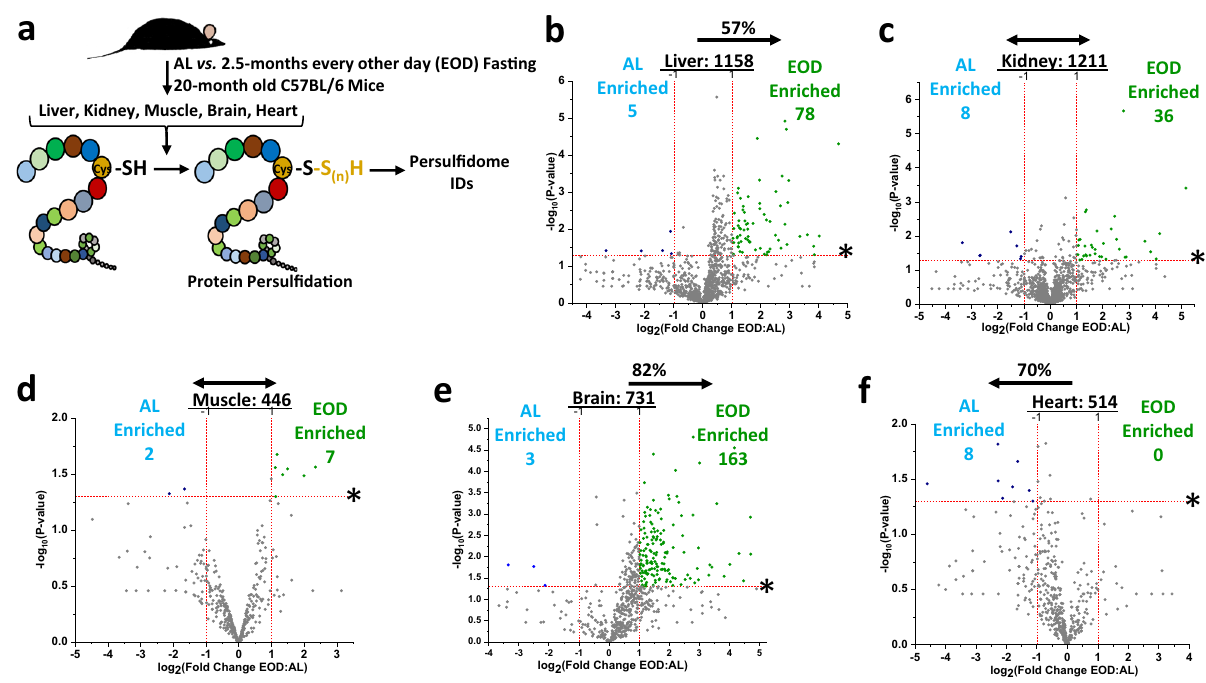
Fig. 5 Late-life initiated every other day (EOD) fasting for 2.5 months transforms tissue-speci fi c persul fi domes similar to short-term DR in young adult mice. a Graphical presentation of the overarching experimental setup. Twenty-month-old male C57BL/6 mice were placed on ad libitum (AL) or Every Other Day (EOD) fasting for 2.5 months prior to tissue collection. Tissues were analyzed for protein persul fi dation via the biotin thiol (BTA) assay. b – f Volcano plots showing differentially abundant persul fi dated proteins in liver ( b ), kidney ( c ), quadriceps muscle ( d ), whole brain ( e ), and heart ( f ) from AL fed ( n = 5 mice/group) versus 2.5 months of EOD fasting ( n = 5 mice/group) 20-month-old C57BL/6 male mice. The log 2 (Fold Change DR:AL) X-axis displays the average fold change in spectral counts for each identi fi ed persul fi dated protein while the − log 10 Y-axis displays the calculated P value from a two-sided Student ’ s t test when comparing the individual spectral count values for each identi fi ed persul fi dated protein in a speci fi c tissue from AL versus EOD fed mice. The non-axial red dotted vertical lines highlight the biological signi fi cance threshold of + / − twofold change in spectral counts between EOD versus AL, while the non-axial red dotted horizontal line with asterisk highlights our statistical signi fi cance threshold of P < 0.05. The number of total persul fi dated proteins identi fi ed in each tissue are given next to the tissue name, while blue (AL enriched) and green (EOD enriched) colored dots and text indicate persul fi dated proteins reaching both biological- and statistical-thresholds. Gray color dots indicate persul fi dated proteins not reaching the criteria for both biological and statistical signi fi cance for enrichment under either diet. The percentage and direction of proteins skewed toward one diet type are provided above the tissue label. See also Supplementary Fig.